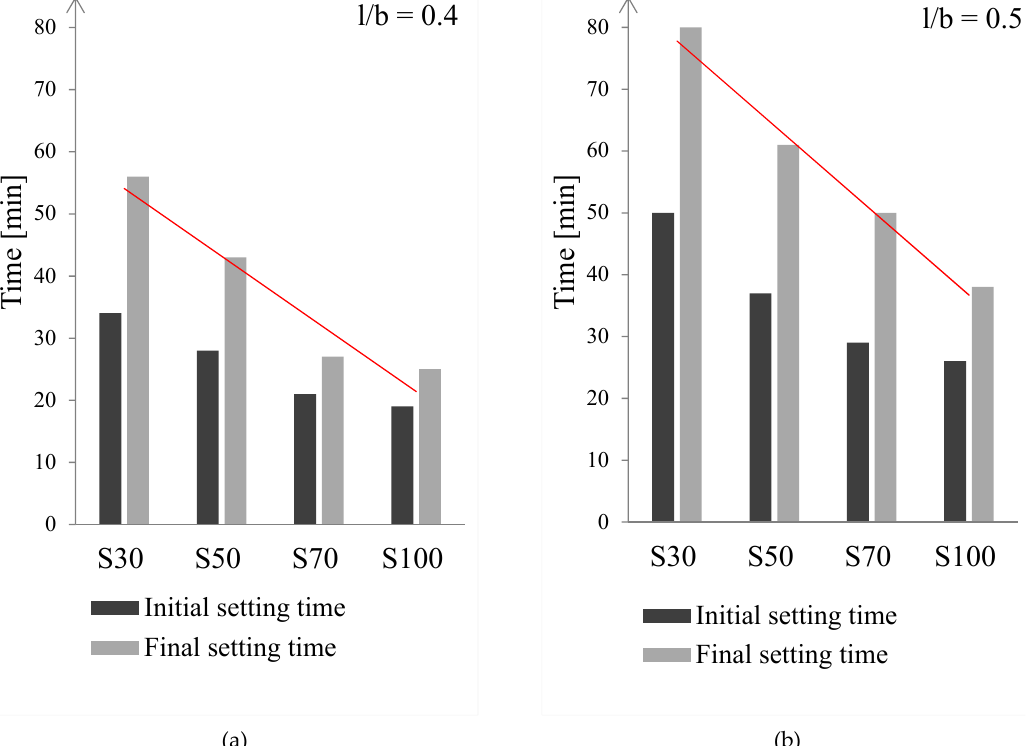
Figure 8. Initial and final setting time of pastes with different l/b ratios: ( a ) l/b = 0.4, and ( b ) l/b = 0.5. The setting time for S0 paste was not plotted due to very long initial setting times (for l/b = 0.4 the initial setting time was 6 h and for l/b = 0.5, it was 14 h).